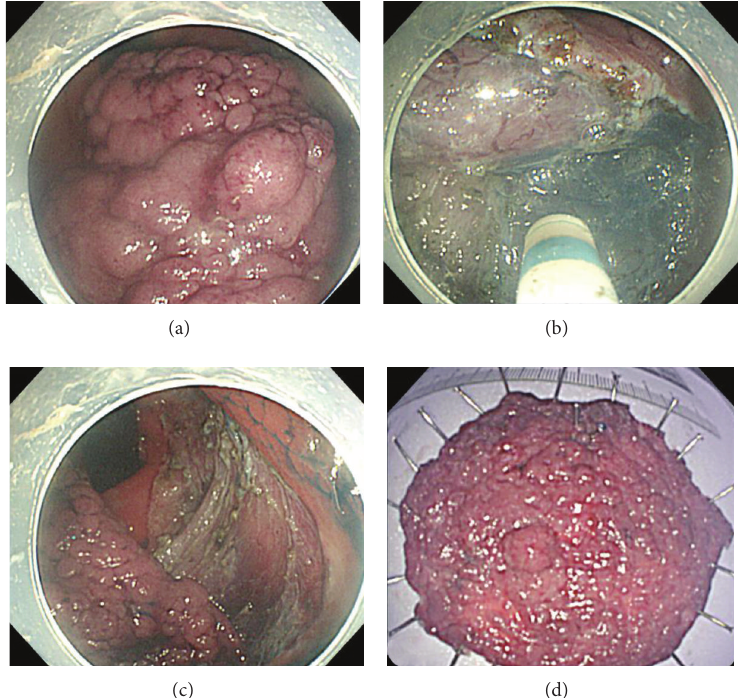
Figure 2: Procedure for colorectal ESD. (a) A large laterally spreading tumor-granular type is seen in the ascending colon. (b) Hyaluronic acid solution is injected into the submucosa, and the submucosal layer under the lesion is directly dissected from the underlying muscularis propria using lateral movement of the dual knife. (c) A huge artificial ulcer is created by ESD. (d) The 80 × 65 mm specimen is completely resected in one piece. ESD: endoscopic submucosal